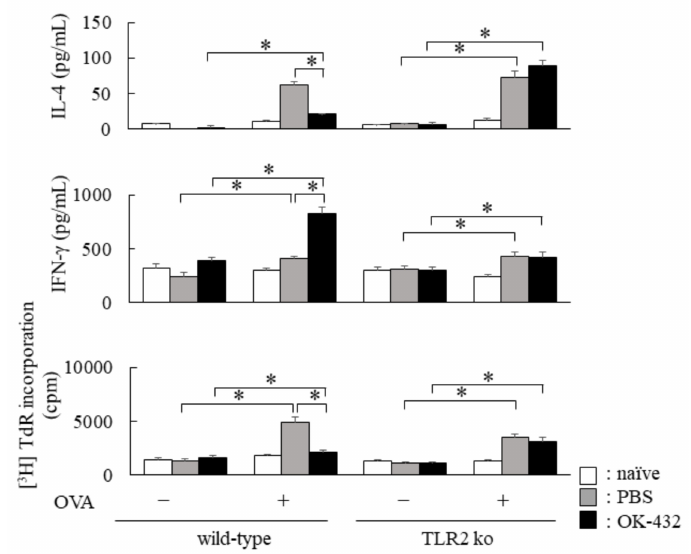
Figure 9. Cytokine production by splenic T cells from OK-432-treated or PBS-treated mice at the induction phase. The enriched T cells (5 × 105 cells) from the spleen of OK-432-treated (black bars) or PBS-treated (hatched bars) mice sensitized with OVA or naive mice (white bars) were cultured with OVA in the presence of MMC-treated spleen cells (5 × 10 5 cells) for 48 h at 37 ◦ C. All mice were immunized with OVA/ALUM. The proliferative responses of splenic T cells was measured by an incorporation of [ 3 H]TdR. IL-4 and IFN- γ production by the splenic T cells was measured by an ELISA. The data are representative of four independent experiments using pooled cells from five mice and are shown as mean of triplicate determinations ± SD. *, p <